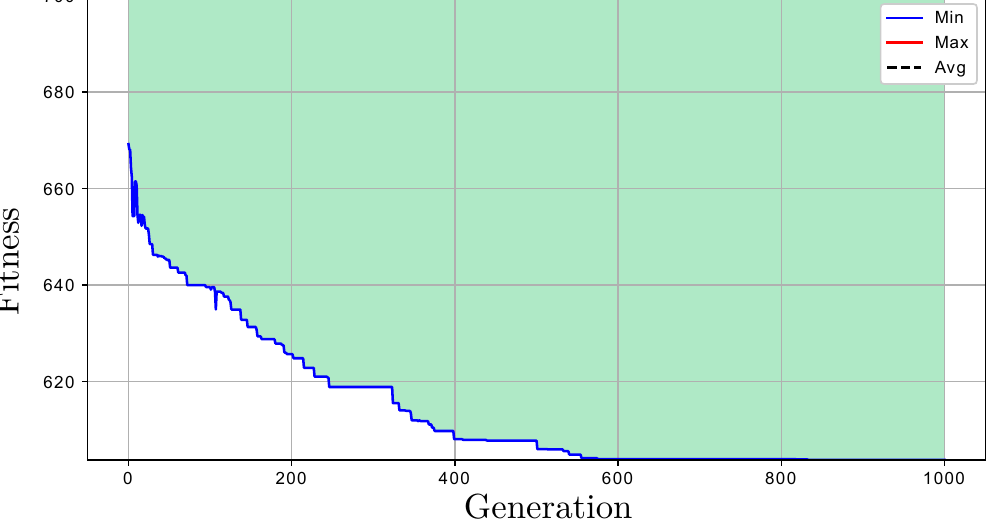
Figure 7. Evolution of the proposed GA, Case Study 1, two-point crossover, p c = 0.6 and p m =